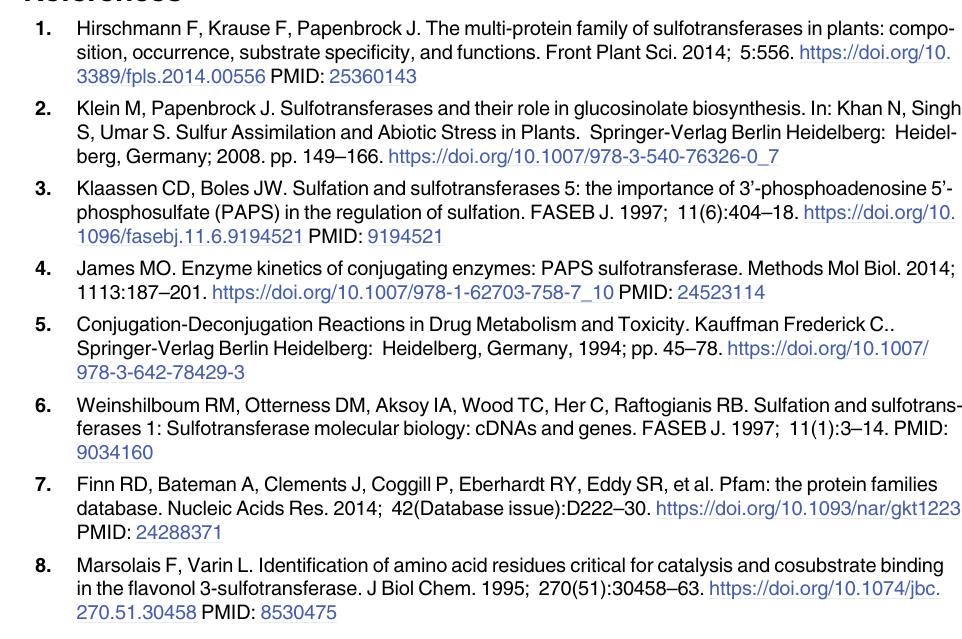
S1 Fig. Before and after the abiotic treatment of B. rapa seedings. S1 Table. qRT-PCR Primers for BraSOTs and control genes. S2 Table. Relative expression level of 56 BraSOT genes in different tissues and after drought, salinity, ABA